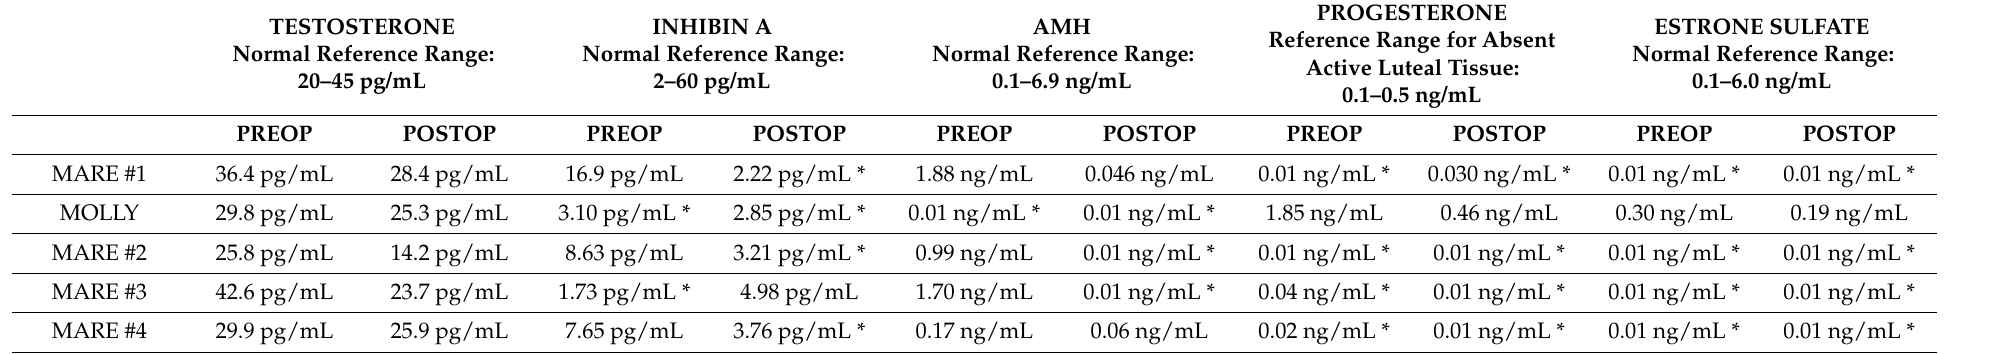
Table 1. Pre- and post-operative endocrine